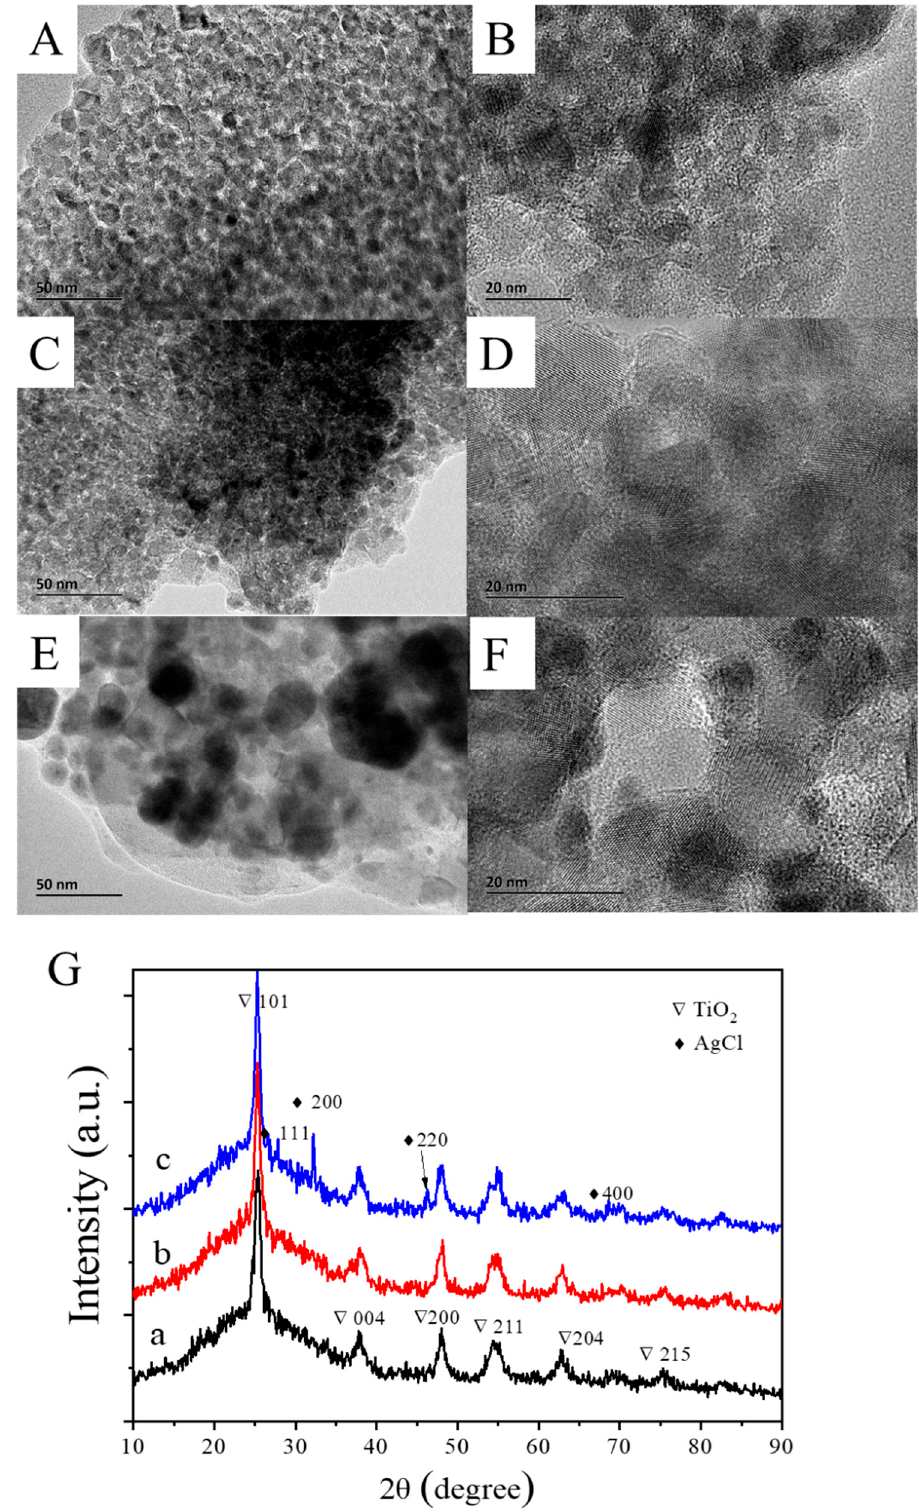
Figure 1. TEM images of TiO 2 ( A , B ), TiO 2 /Ag + ( C , D ), TiO 2 /Ag[BMIM]Cl ( E , F ), and XRD patterns ( G ) of the TiO 2 (a), TiO 2 /Ag + (b) and TiO 2 /Ag[BMIM]Cl